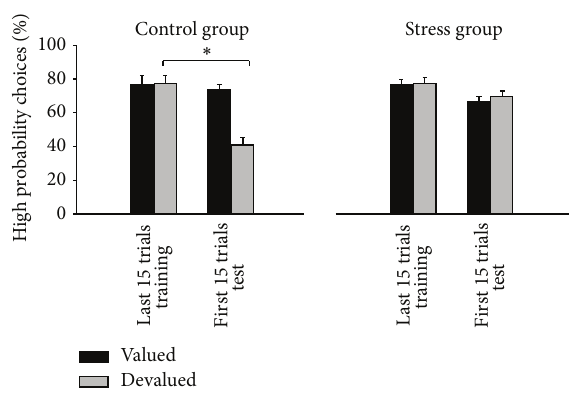
Figure 11: Percent of high probability actions of controls and stressed participants in the last 15-trial block of training and the first 15-trial block of extinction testing